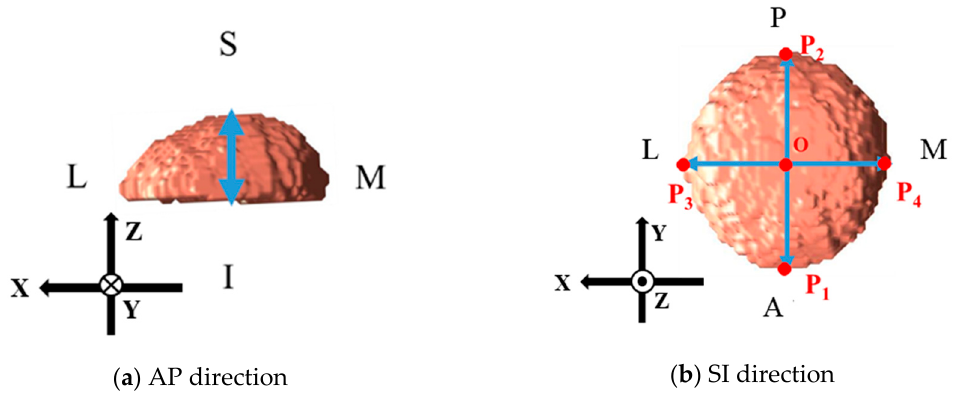
Figure 4. The flow of extracting the humeral head from the humerus (S: superior, I: inferior, L: lateral, M: medial).